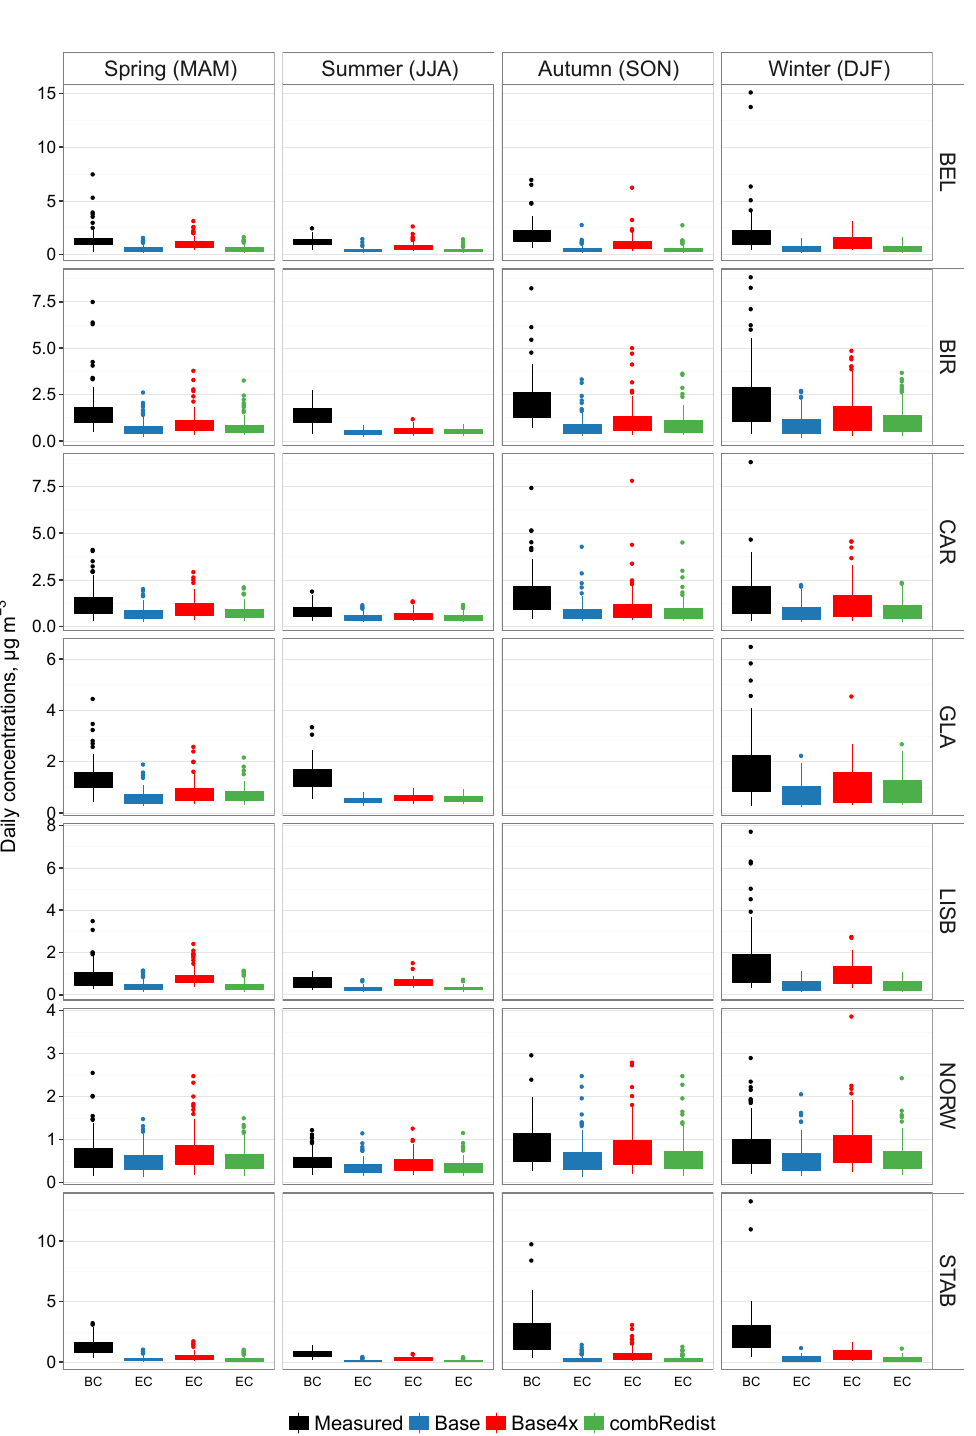
Figure 14. Seasonal box plots of daily average concentrations of measured BC and modelled EC concentrations at the BC-network measure- ment sites, year 2012. Site name abbreviations are given in Fig. 12. Each box is the interquartile range – IQR, whiskers extend to 1.5 × IQR, and all daily values beyond the whiskers are plotted